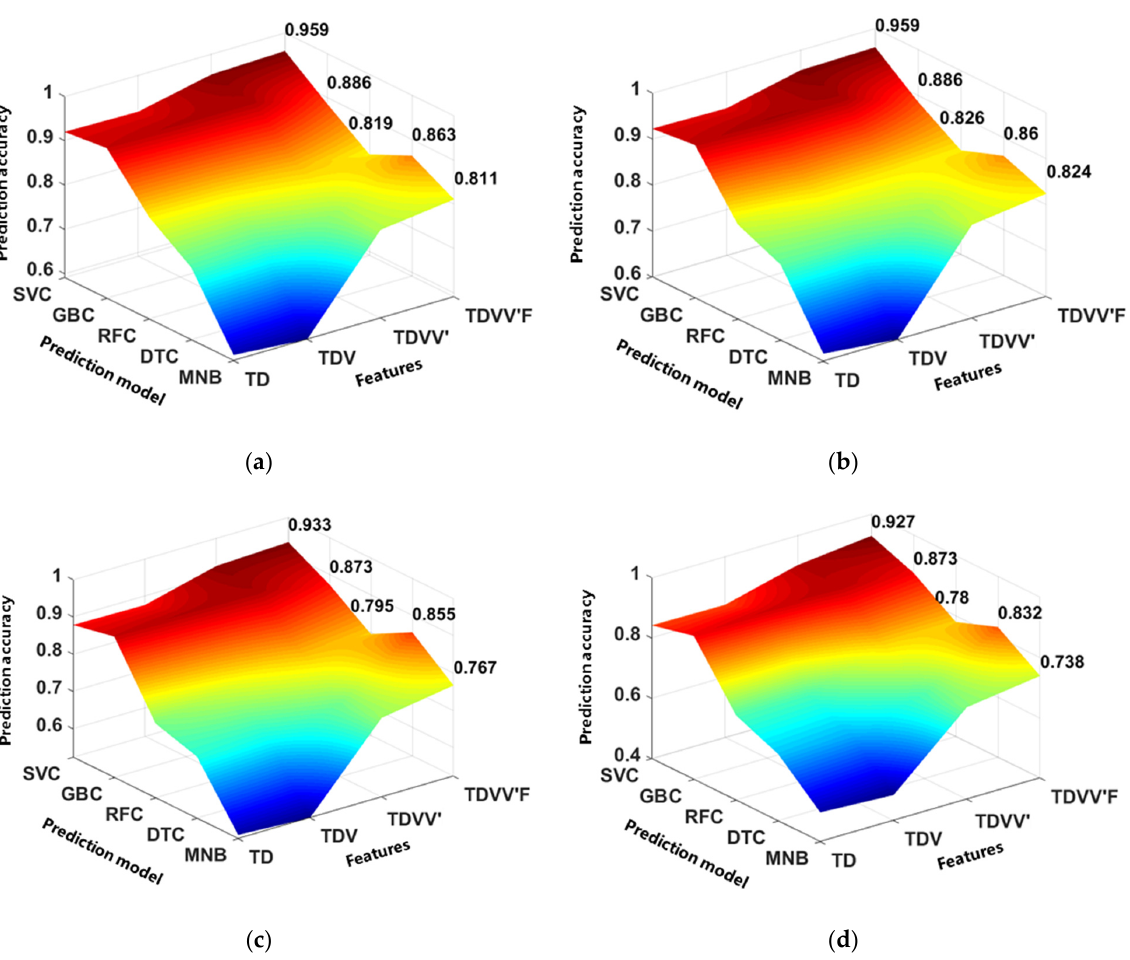
Figure 6. Prediction accuracy of different models. ( a ) Identifier Threshold = 0.5, ( b ) Identifier Threshold = 0.6, ( c ) Identifier Threshold = 0.7, ( d ) Identifier Threshold =